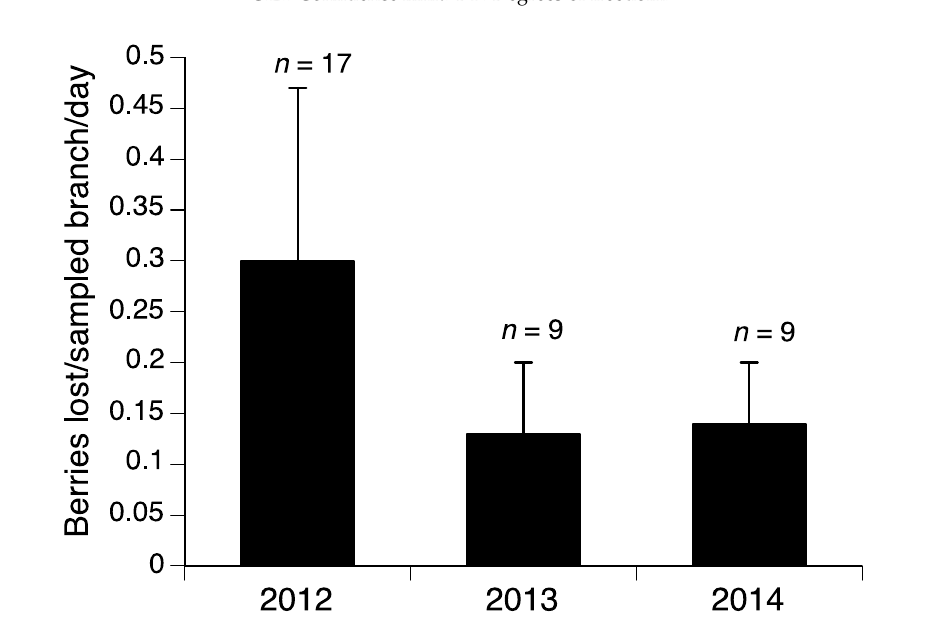
Figure 1. Blueberries lost to birds in Michigan ‘Bluecrop’ fields. Error bars are standard deviations. n = number of blocks sampled. Table 3. Models compared for influences-on-bird-damage to blueberries.